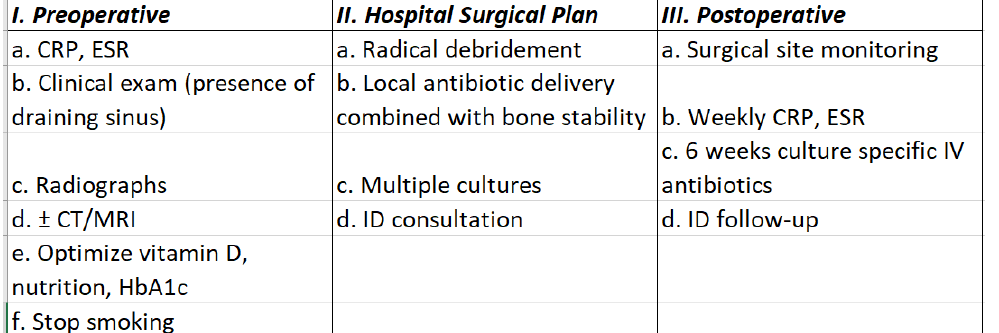
Figure S4: AP and lateral postoperative plain radiographs showing hindfoot fusion using an ACCIN and a missing (excised) distal segment of the fibula. Notice, the cement coating on the tip of the nail (gray arrow). Figure S5: Clinical photos of the leg condition during follow-up. Figure S6: AP and lateral radiographs at the final follow-up showing united ankle fusion at the final follow-up. Figure S7: Clinical photographs showing the patient fully weight bearing on both lower limbs. Front and side views of the left foot and ankle show the skin condition at the last follow-up.